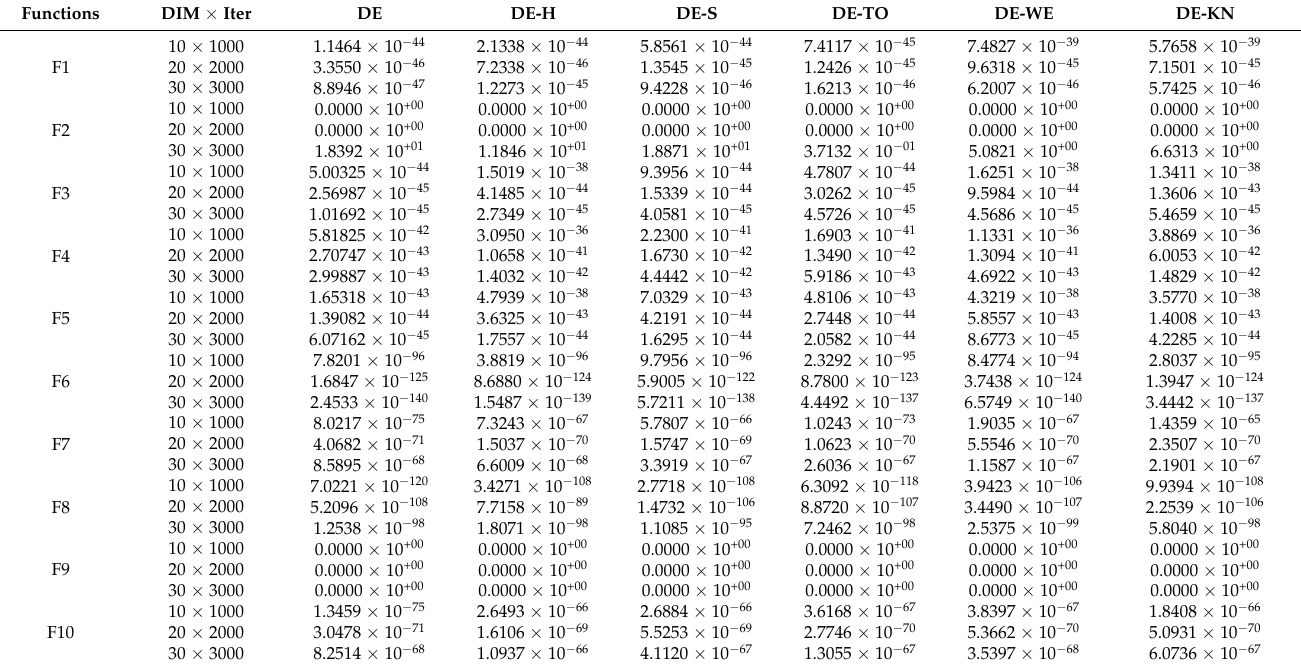
Table 6. Comparative results for all DE-based approaches on 16 standard benchmark